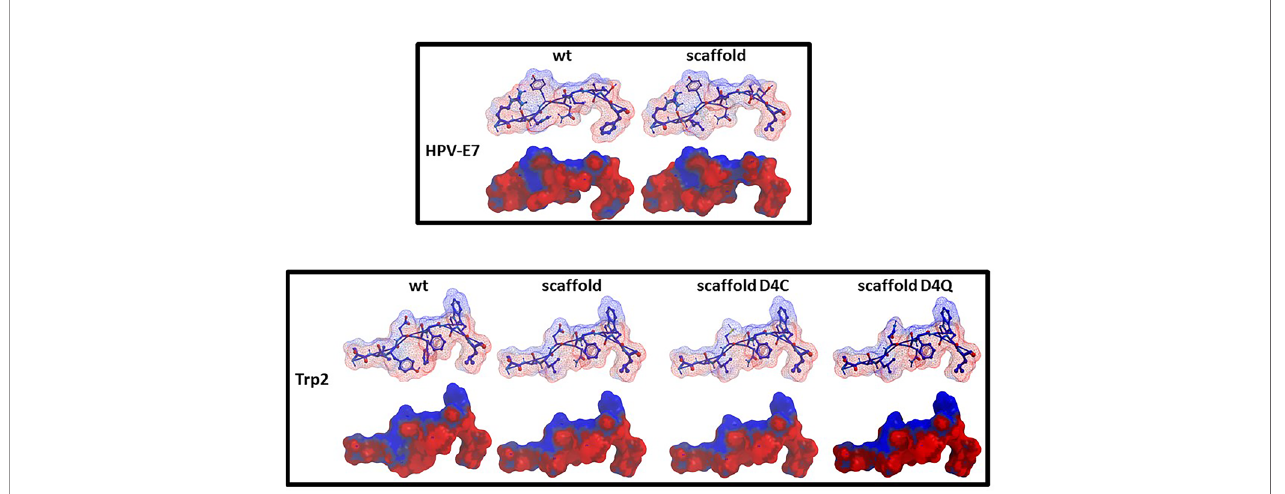
FIGURE 5 | Predicted conformation of scaffold peptides. The conformation of the HPV-E7 and Trp2 scaffold peptides, bound to the H2-Db molecule, is shown compared to the wt sequence. Contact pattern to the H-2Db is indicated in red; contact pattern to TCR is indicated in blue.